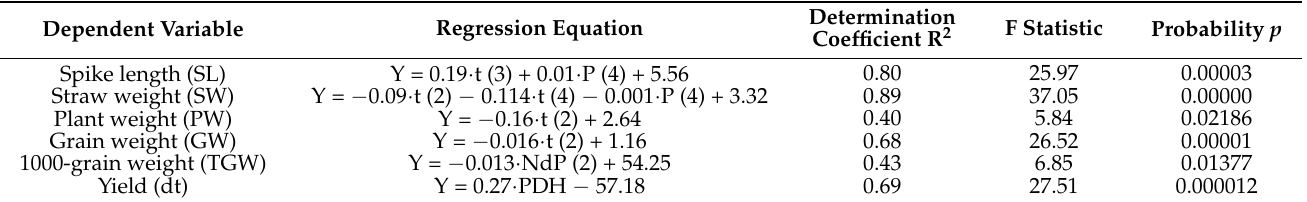
Table 5. Relationships linking biometric parameters of winter wheat and yield elements with selected meteorological parameters. Dependent Variable Regression Equation